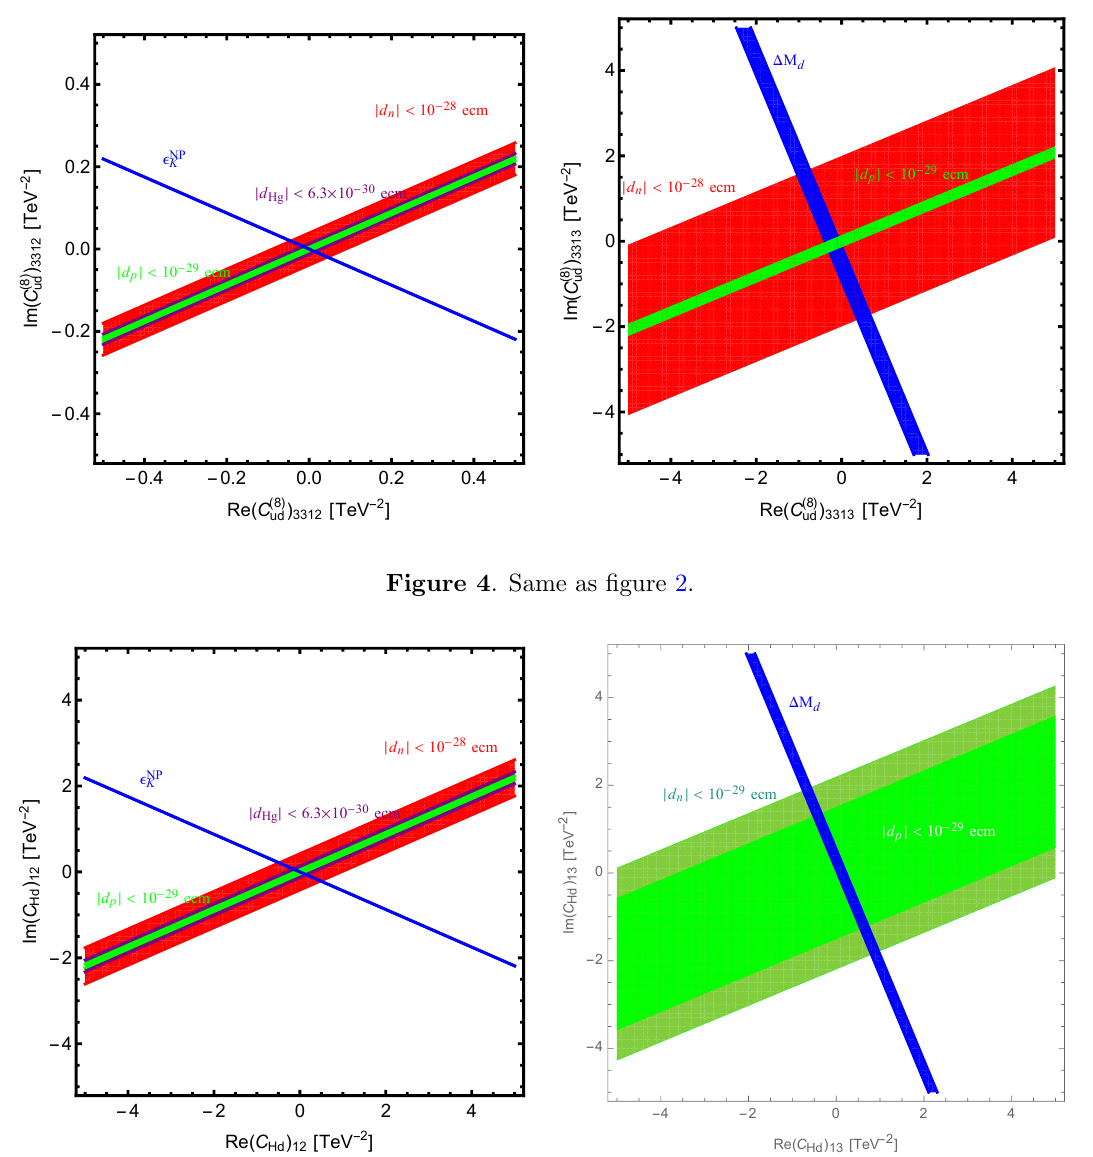
Figure 5 . Same as (cid:12)gure 2, but the deep green region in the right panel is j d n j < 10 (cid:0) 29 e cm, which is one order of magnitude weaker than the future